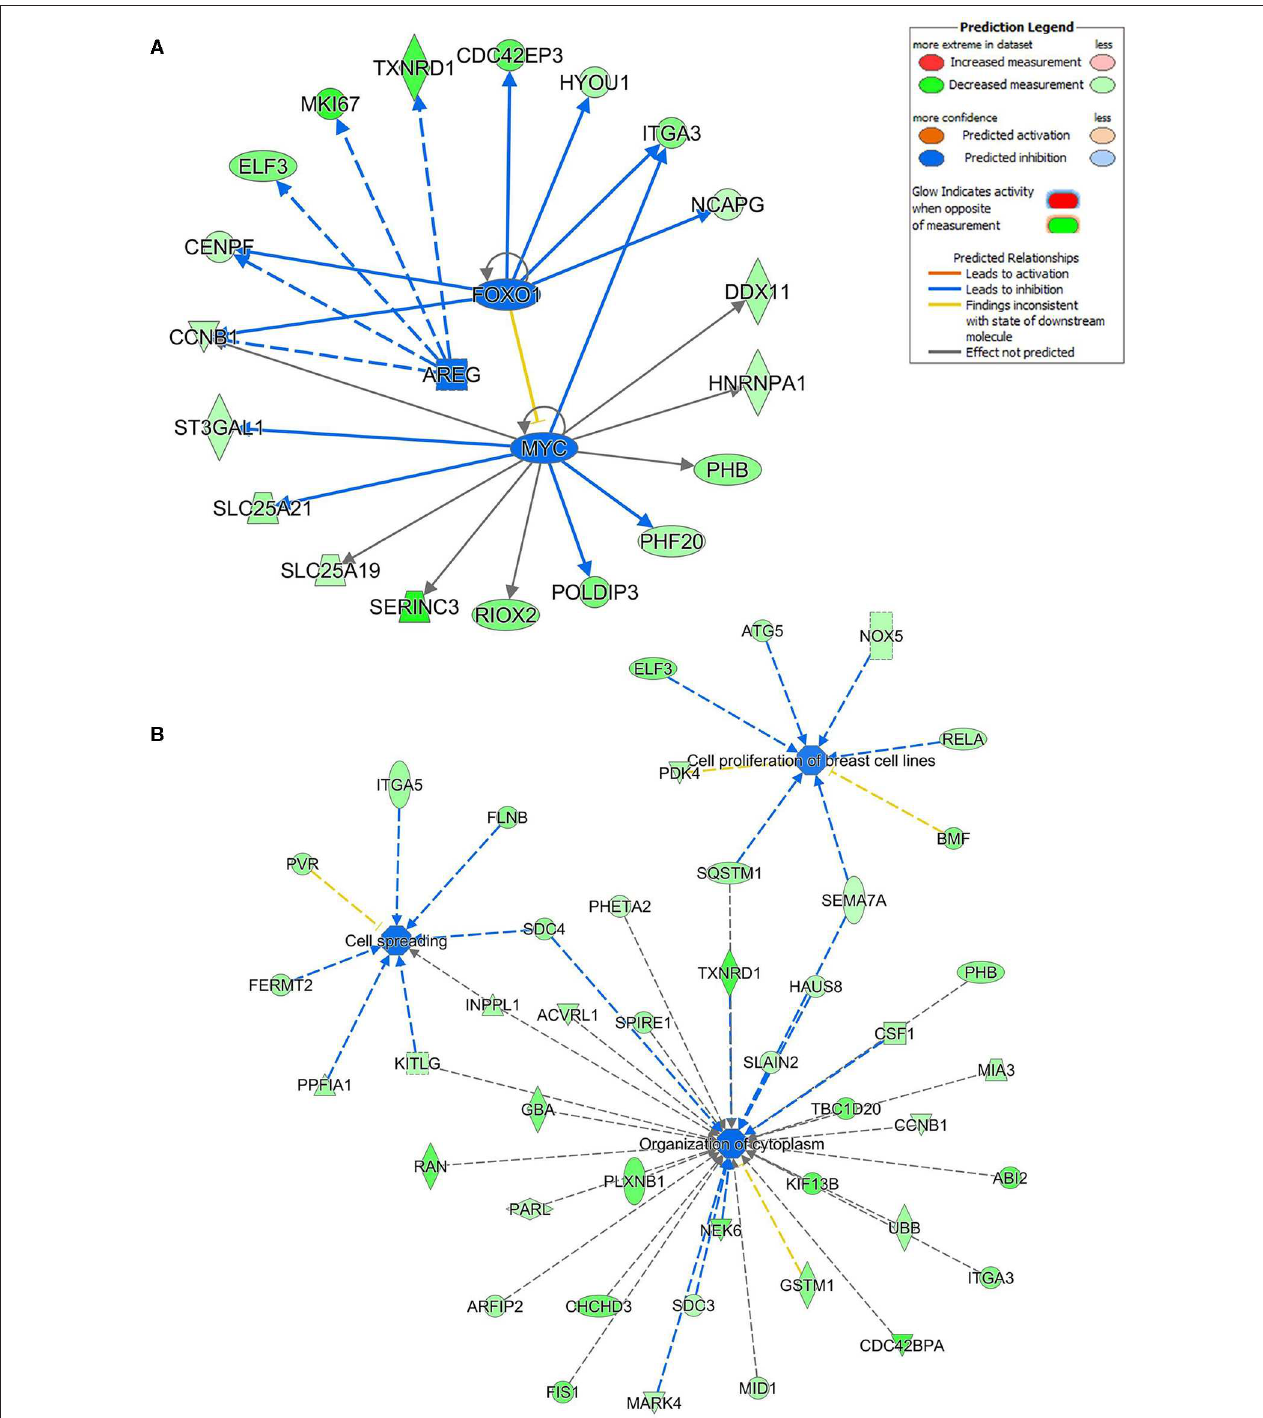
FIGURE 5 | Multiple signaling networks are regulated by hsa-miR-205-5p based on ingenuity pathway analysis (IPA). (A) Illustration of the top inhibited mechanistic networks (FOXO1, AREG and MYC) based on the identified hsa-miR-205-5p gene targets and IPA analysis. (B) Functional networks illustrating the involvement of the indicated hsa-miR-205-5p gene targets in regulating cell proliferation, cell spreading, and organization of cytoskeleton functional based on IPA analysis.